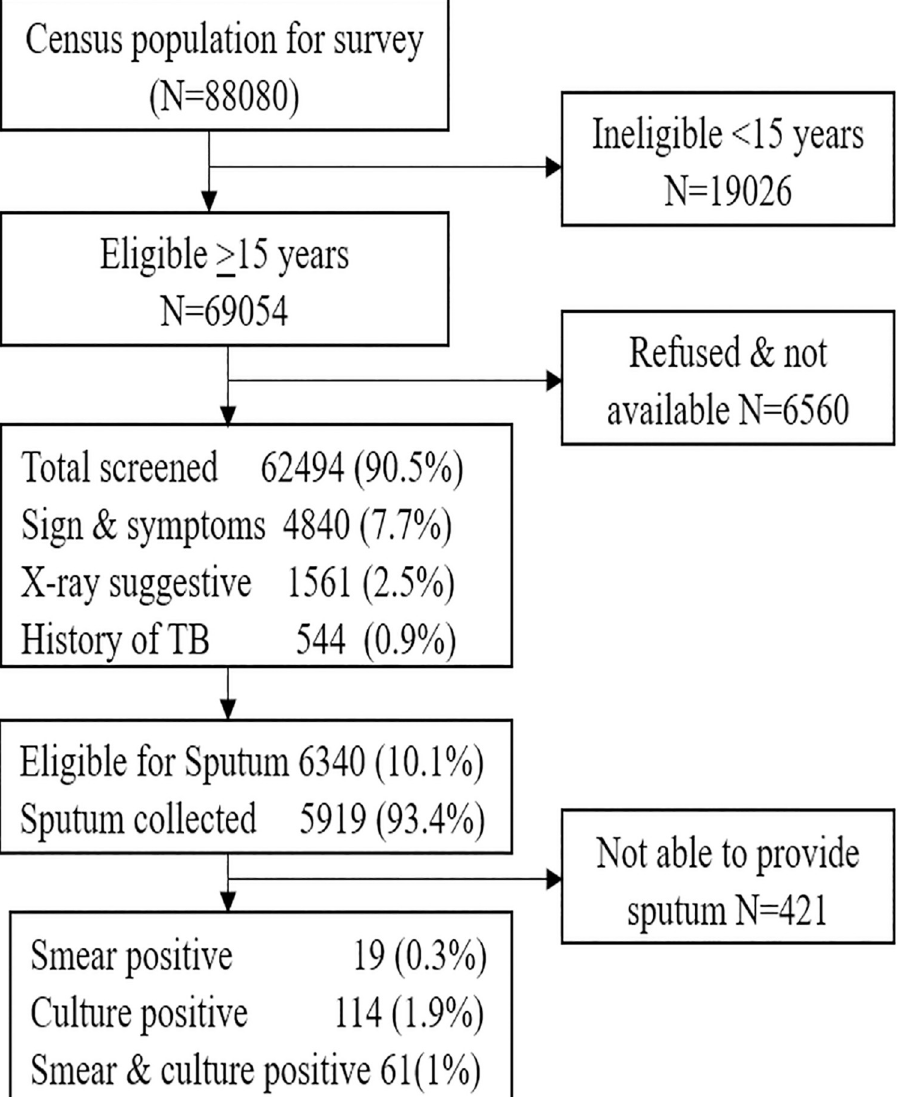
Fig 1. Study population and its